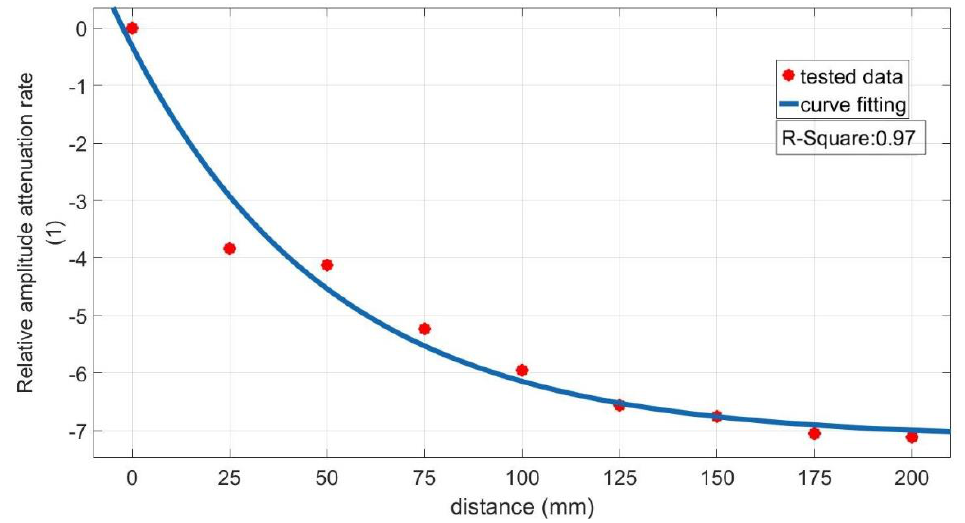
Figure 7. Relationship between relative amplitude attenuation rate and the propagation distance.